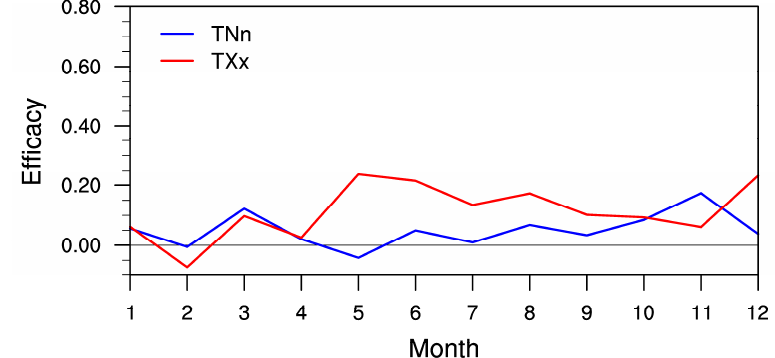
Figure 12. Timeseries of monthly efficacy of the G4cdnc experiment for neutralizing extreme (TNn and TXx) temperatures during the termination period for the RCP4.5 scenario over East Asia. Results are shown for multi‐model ensemble mean, excluding MIROC‐ESM model.